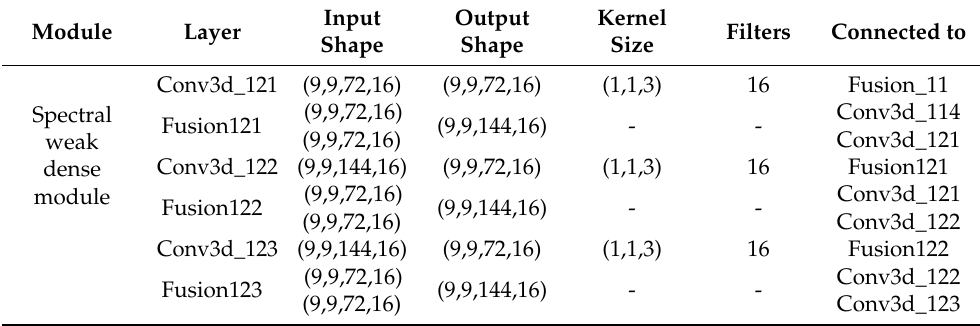
Table 3. The implementation details of the spectral weak dense feature extraction